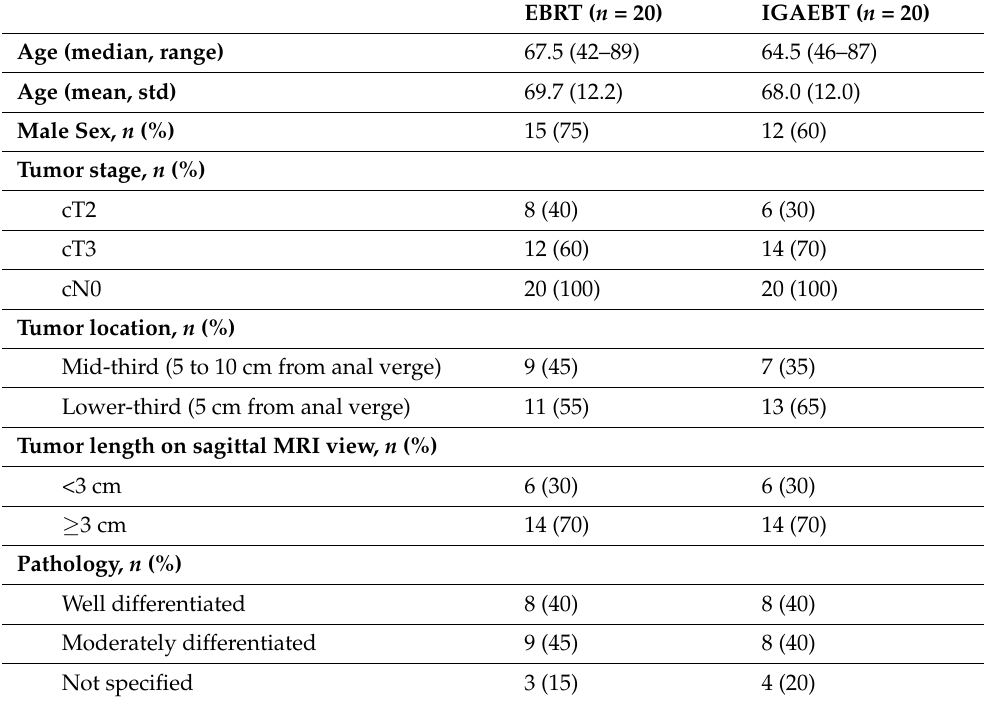
Table 1. Patient and tumor characteristics by study arm.